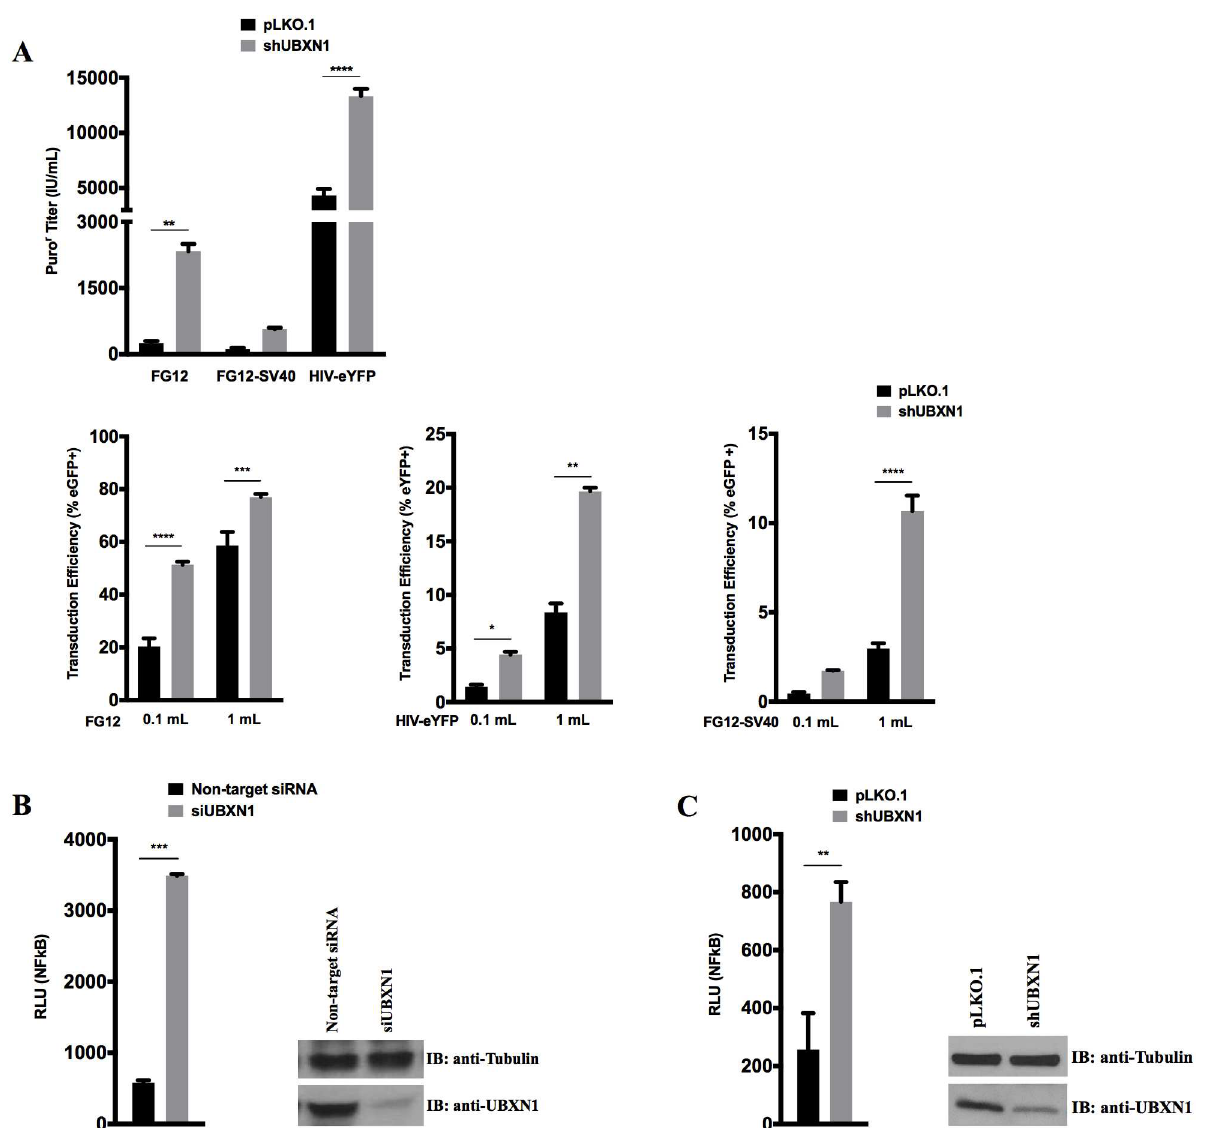
Fig 5. Knockdown UBXN1 results in enhanced retroviral vector production and NF κ B signaling. (A) Quantification of HIV vector production after co-transfection of third-generation HIV-basedvector encoding both anti-UBXN1 shRNA and puro r gene (vs. control, empty vector), along with VSV G and either FG12, HIV-eYFP, or FG12-SV40 into 293T cells. FG12 is a third generation,self-inactivating HIV vector that encodeseGFP driven by the UbiC promote; FG12-SV40 is similar except it has an internalSV40 promoter driving eGFP. Top: puro r titer on HOS targets; Bottom: percentageof eYFP/eGFP+ HOS targets as measured by flow cytometry for each of the three vectors, using two different amounts of indicatedvector supernatant; (B) (left) Quantification of NF κ B-FFLUC reporter in HEK293cells after siRNA knockdown of UBXN1, comparedto Trilencer-27 Universalscramblednegative control siRNA; (right) corresponding immunoblot of UBXN1 and β -tubulin in presenceof either control or anti-UBXN1 siRNA. FFLUC values were normalized to those of co-transfected Renilla luciferase reporter; cells were stimulatedfor 4 h with 5 ng/mL of TNF α 48h post-transfection. ( C ) Similar to (B) except that either empty HIV vector pLK0.1 or vector encodinganti-UBXN1 shRNA was transfected into HEK293cells, with corresponding immunoblot shown on right. Data represent mean ± SEM (n = 3). * p < 0.05, ** p < 0.005, *** p < 0.0005, **** p < 0.0001by two-way